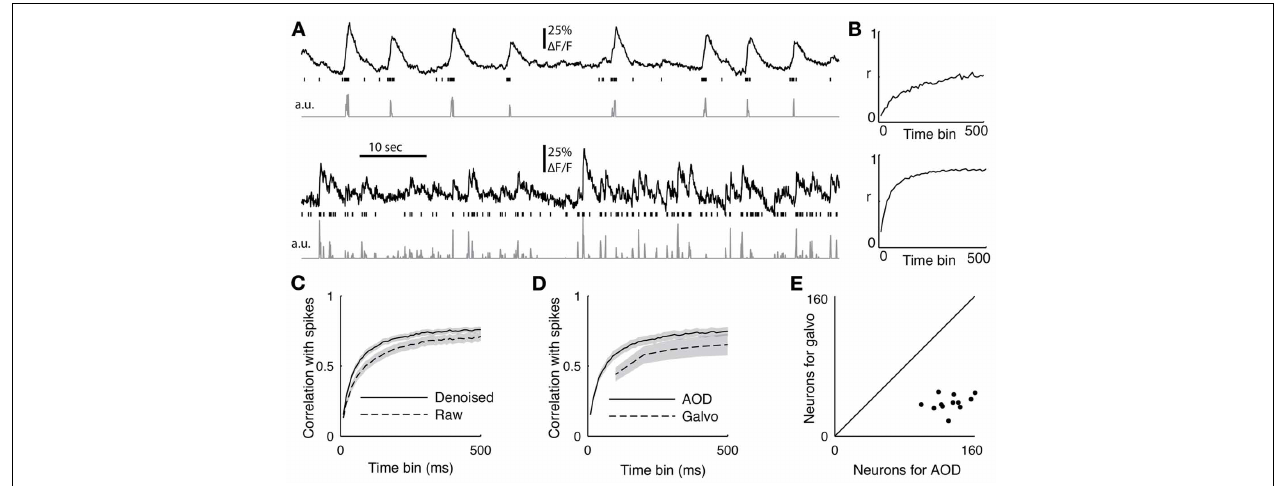
FIGURE 6 | (A) Two sample cells recorded with functional imaging and electrophysiology. The top trace shows the downsampled fluorescence trace, the vertical lines show when spikes occurred, and the bottom trace is the deconvolved fluorescent trace. (B) The correlation coefficient between the spiking and the deconvolved trace binned at different time scales from 10 to 500ms for the two sample cells (C) The average correlation coefficient between 18 cells with juxtacellular recordings and their firing rate inference comparing removing the first principal component